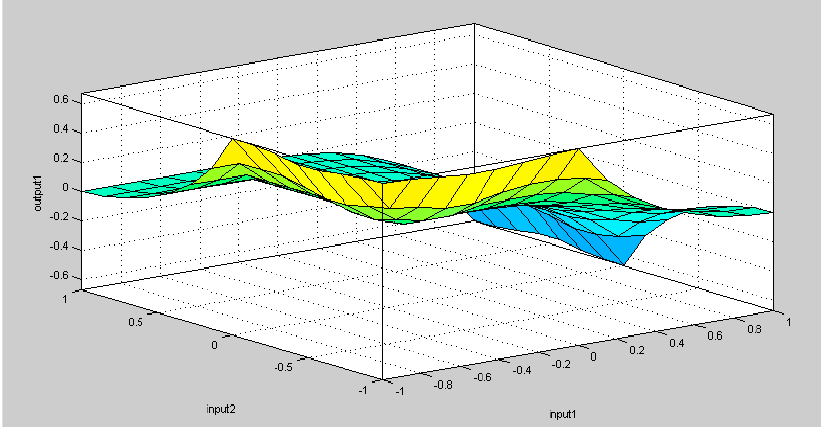
Figure 12. Surface viewers for fuzzy rule for the seven membership functions.